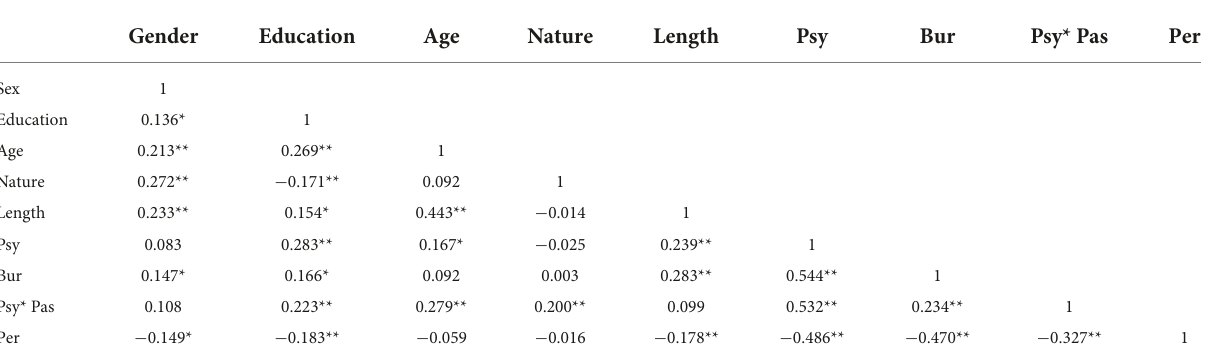
TABLE 3 Correlation analysis of the variables.